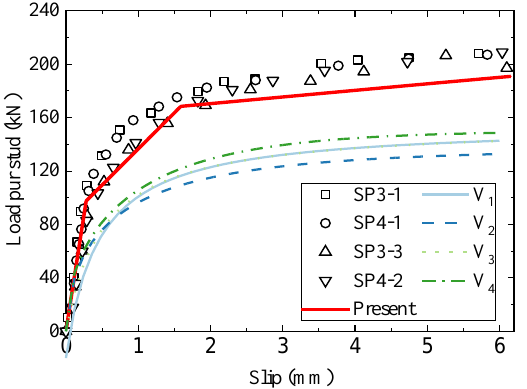
Figure 8. The comparison of load–slip curves between the test, empirical formulae, and the analytical method for SP3/4-1/3.